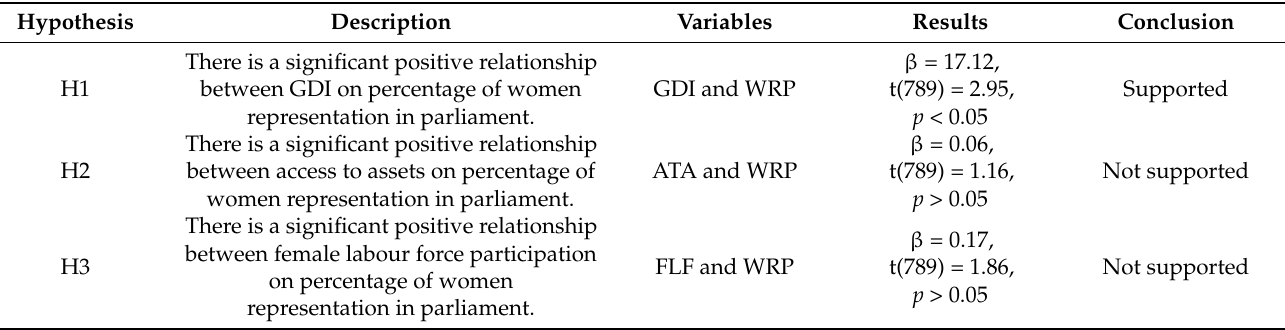
Table 5. Summary of hypothesis